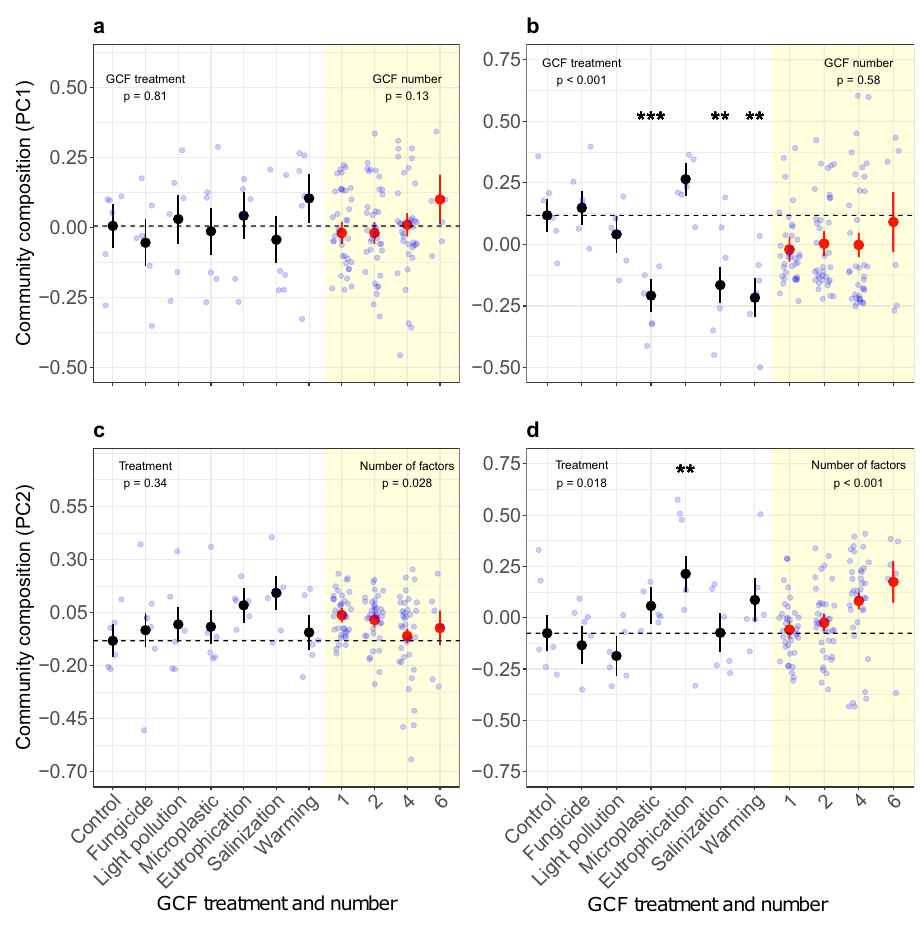
Fig. 2 | Comparison of single-GCF and GCF-number effects on the species composition of sown and transplanted-seedling communities. Species com- position of transplanted-seedling ( a , c ) and sown ( b , d ) grassland communities exposed to different single-GCF treatments (black circles) and to different num- bers of simultaneously acting GCFs (red circles). Species composition was quan- ti fi ed as the fi rst (PC1; a , b ) and second (PC2; c , d ) axes of a principal component analysis on the proportional biomass of species. In the sown communities, there were signi fi cant effects of microplastics ( p <0.001), salinization ( p =0.001), and warming ( p =0.001; PC1; b ), as well as eutrophication ( p =0.008; PC2; d ) on the community composition (Supplementary Table 2). GCF number had signi fi cant